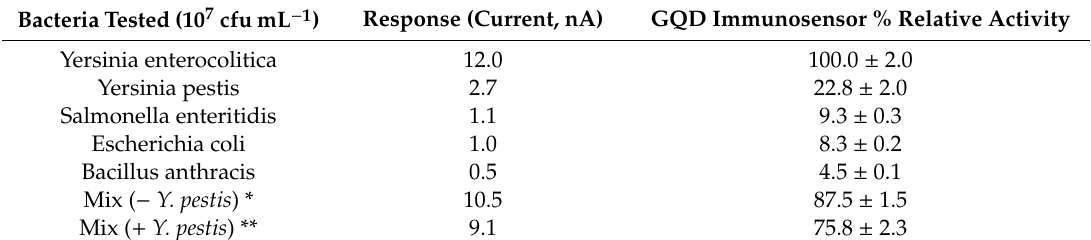
Table 3. Current response profile for Y. enterocolitica binding in human serum compared with other pathogenic bacteria, and the percentage of cross reactivity of non-specific bacteria ( n =